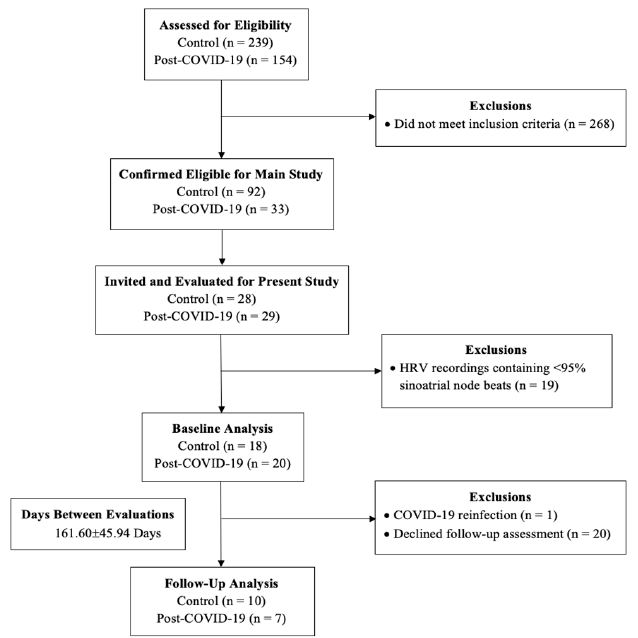
Figure 2. Flow diagram of the study.